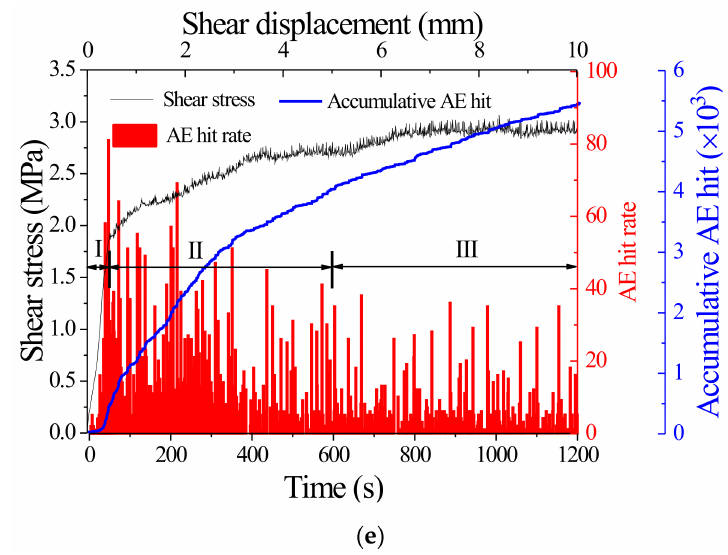
Figure 12. Difference of AE hit rate and cumulative AE hit of joints under diverse normal stiffness status. ( a ) For k n = 0; ( b ) For k n = 1 MPa/mm; ( c ) For k n = 3 MPa/mm; ( d ) For k n = 5 MPa/mm; ( e ) For k n = 7